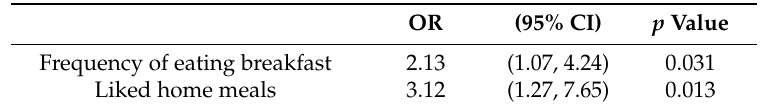
Table 3. Means and 95% confidence intervals of food habits by self-rated health in high school students after covariate adjustment.